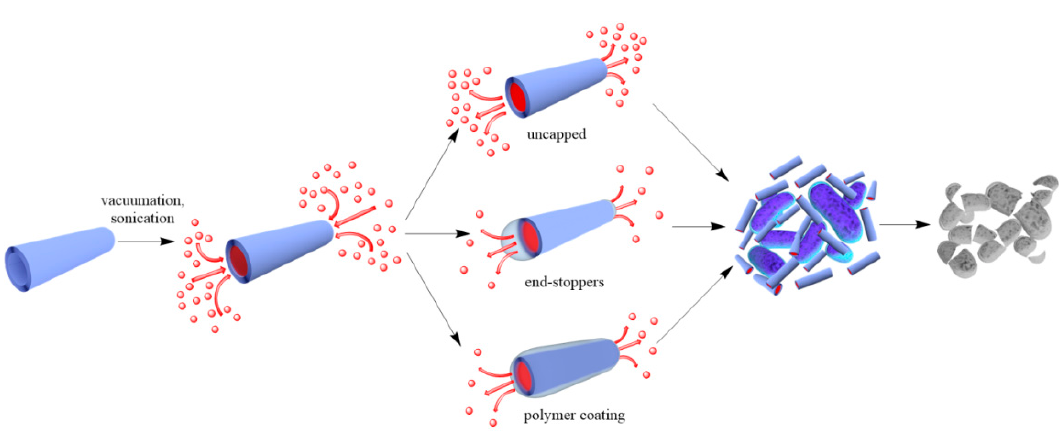
Figure 2. A scheme of antibacterial compound loading into halloysite lumens.